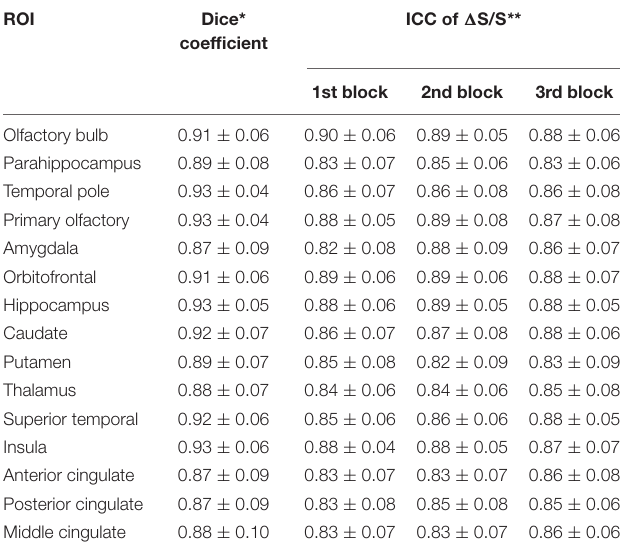
TABLE 4 | Reproducibility for positively activated voxels in T2prep BOLD fMRI ( n = 14). ROI Dice* coefficient